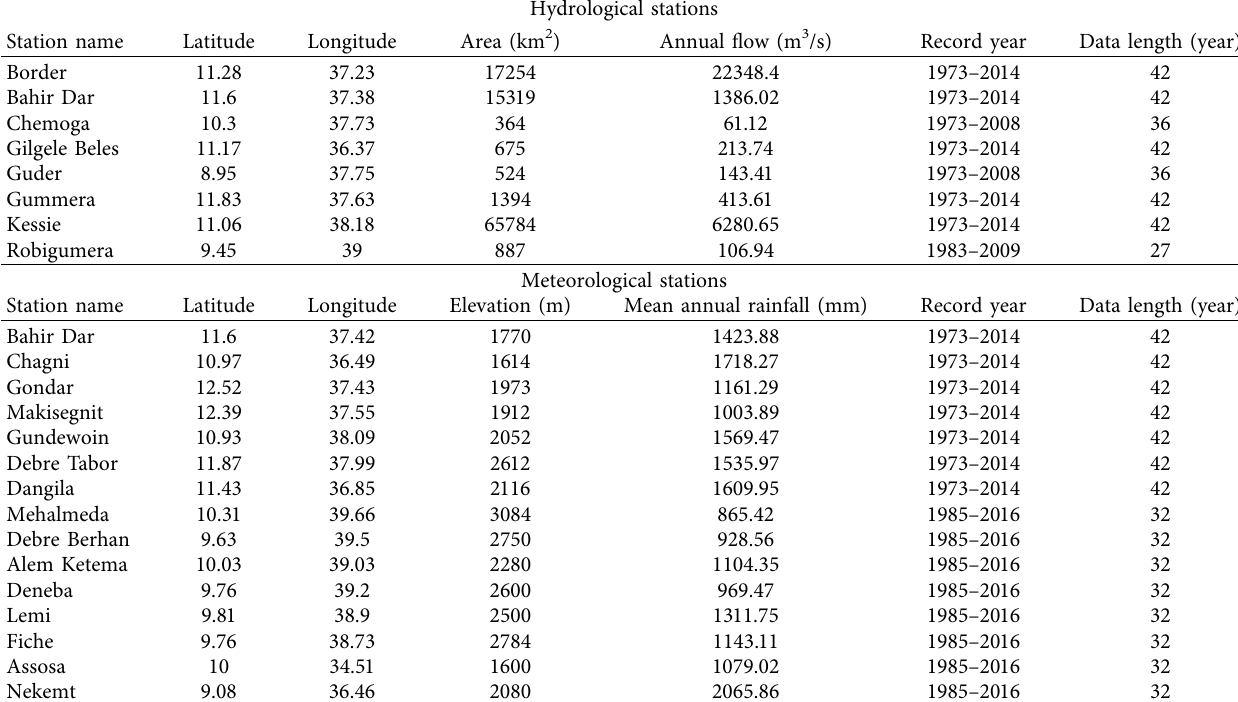
Table 1: Selected hydrometeorological station location in Abbay river